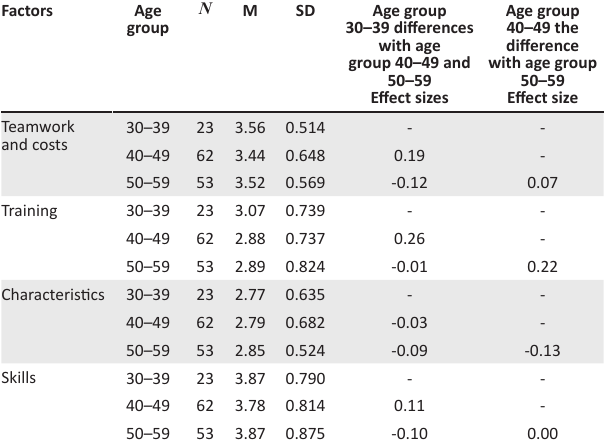
TABLE 5: Comparison of mean scores between age groups. Factors